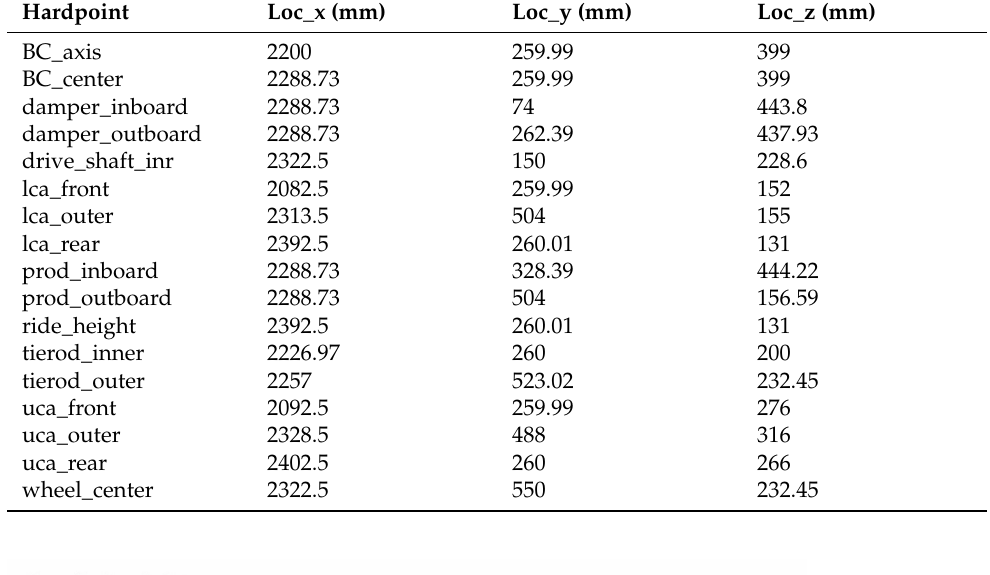
Table A3. Hardpoint locations of the rear right suspension expressed in the model global reference system.